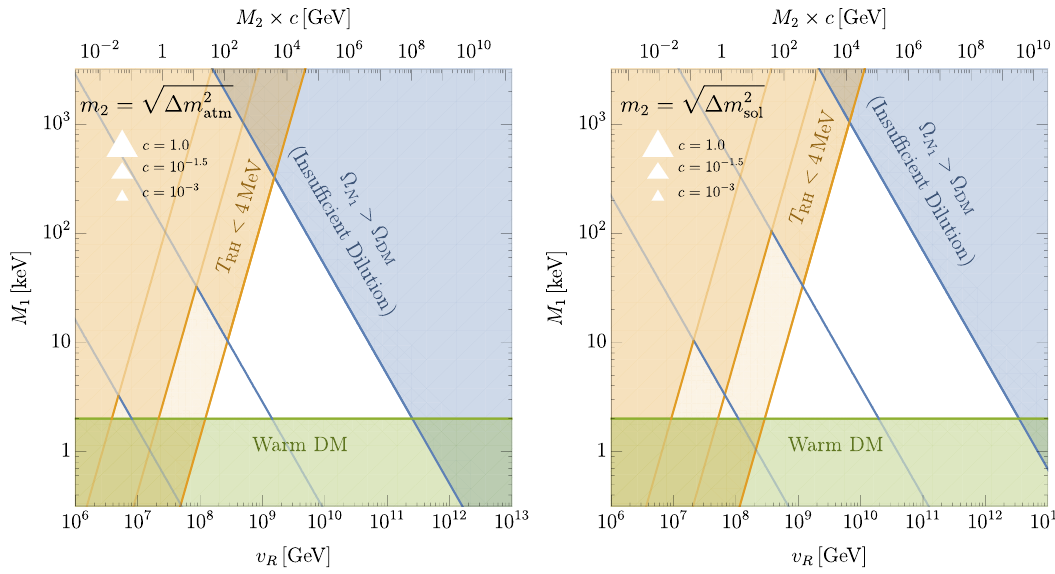
Figure 1 . The parameter space of N 1 DM produced by relativistic freeze-out and dilution from N 2 decay: constraints on the LR symmetry breaking scale v R and the mass N 1 . The constraints from warm DM are in green , Big Bang Nucleosynthesis in orange , and insu(cid:14)cient dilution in blue . The constraints depend on the LR-model dependent parameter c . 1. Left : we (cid:12)x the (cid:23) 2 mass by p the atmospheric neutrino mass di(cid:11)erence, m 2 = (cid:1) m 2 . Right : we (cid:12)x the (cid:23) 2 mass by the solar p atm neutrino mass di(cid:11)erence, m 2 = (cid:1) m 2 sol